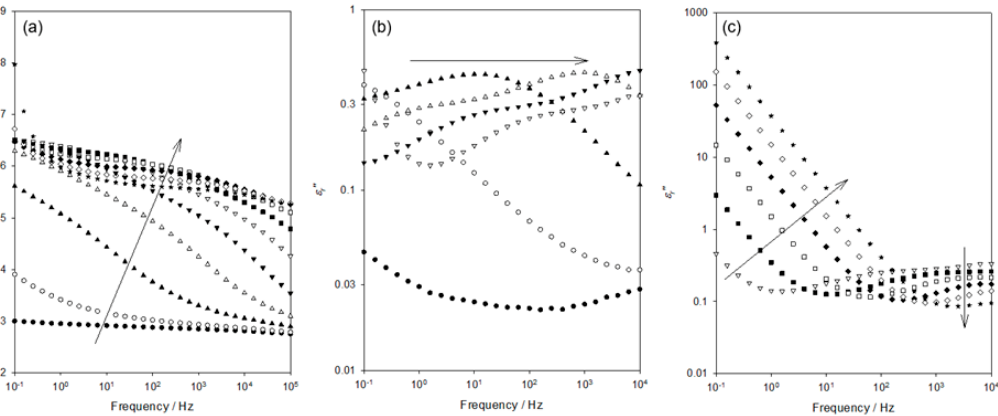
Figure 5. Dielectric spectra acquired at temperatures of 203 K ( ), 213 K ( ), 223 K, ( ), 233 K ( ), 243 K ( ), 253 K ( ), 263 K ( ); 273 K ( ), 283 K ( ), 293 K ( ), and 303 K ( ). Frequency depend- ence of the: ( a ) real part of the relative permittivity, ε r ′ ; imaginary part of the relative permittivity, ε r ′′ at: ( b ) 203–253 K and ( c ) 253–303 K.